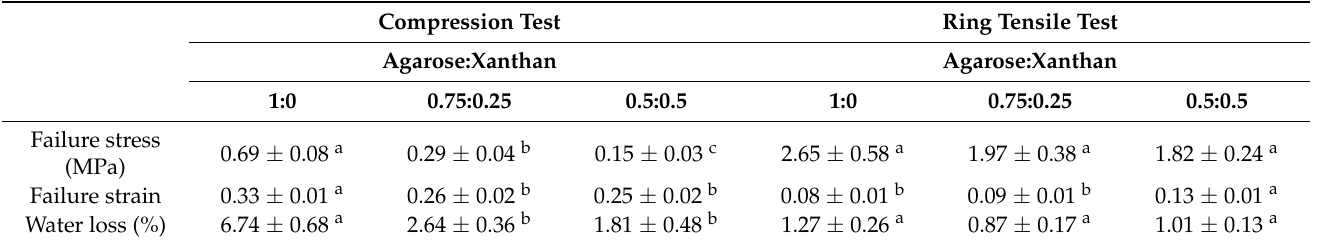
Table 2. Failure stress, failure strain, and water loss of agarose-xanthan gel systems measured by mechanical tests.